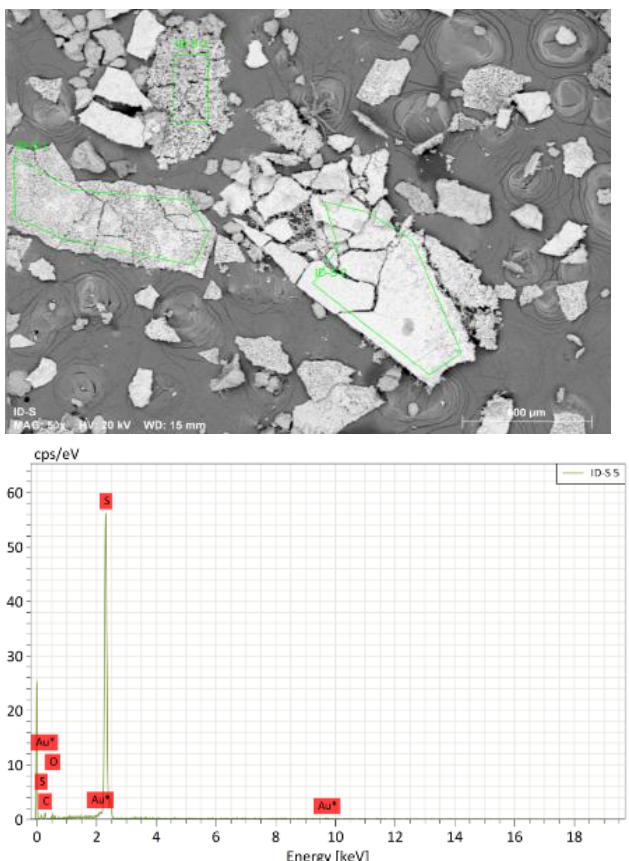
Figure 7. Microphotography and X-ray diffraction microscopy (EDX) of a sample taken from the sulphurous source.